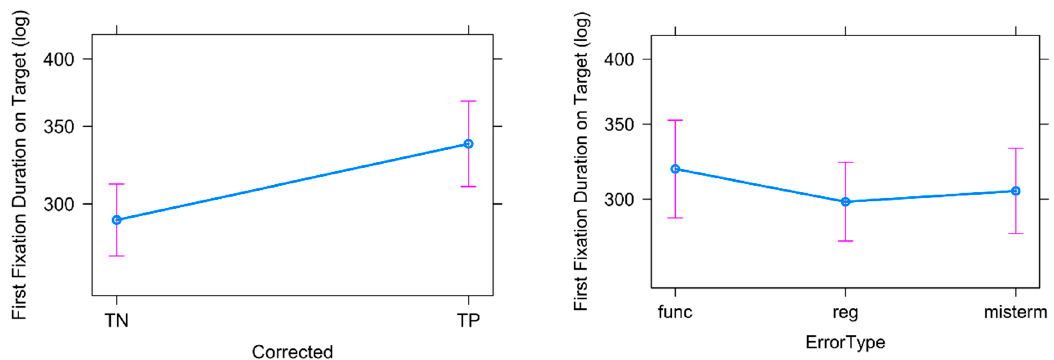
Figure 16. Effect of Corrected ( left ) and Error Type ( right ) on target text first fixation durations.